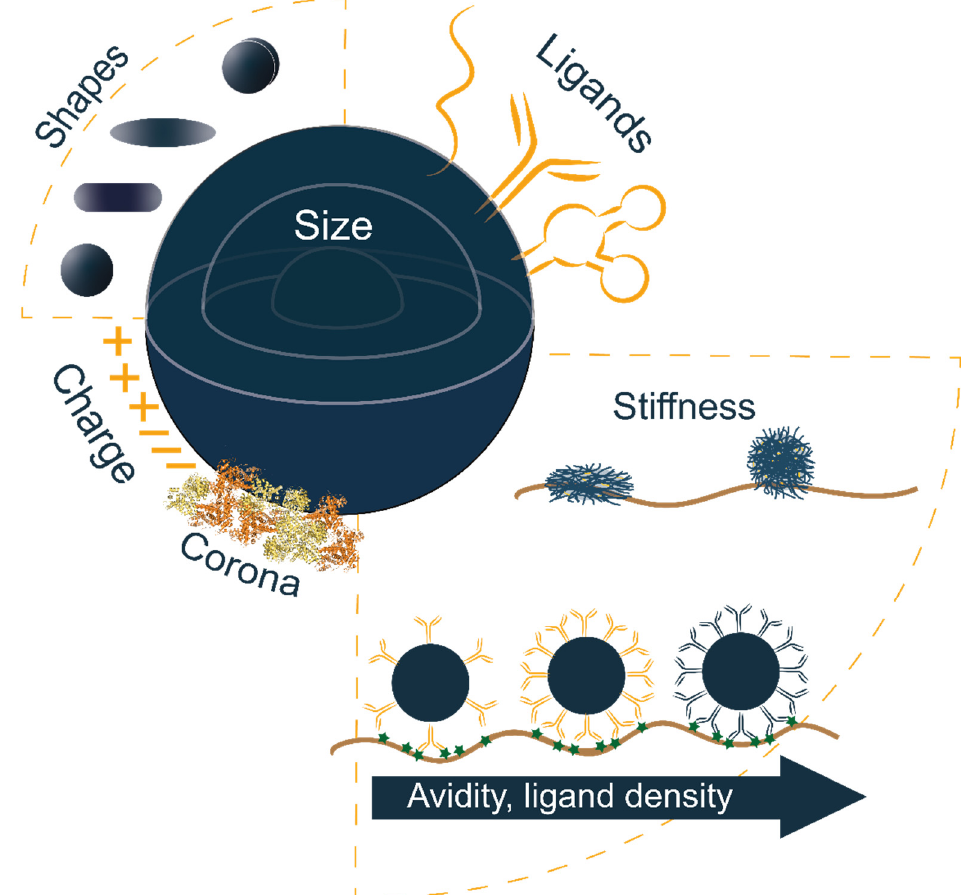
Figure 2. Schematic representation of a polymeric drug delivery system and its tunable properties. This summarizes the main properties of polymer-based nanocarriers for controlling the interaction with biological systems and improving delivery efficacy. Human serum albumin (HSA) protein structure in “Corona” was adapted from the Protein Data Bank (http://www.pdb.org, accessed on